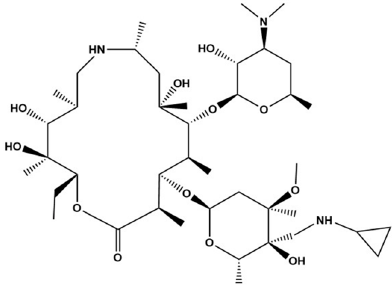
Figure 1. Chemical structure of lekethromycin.